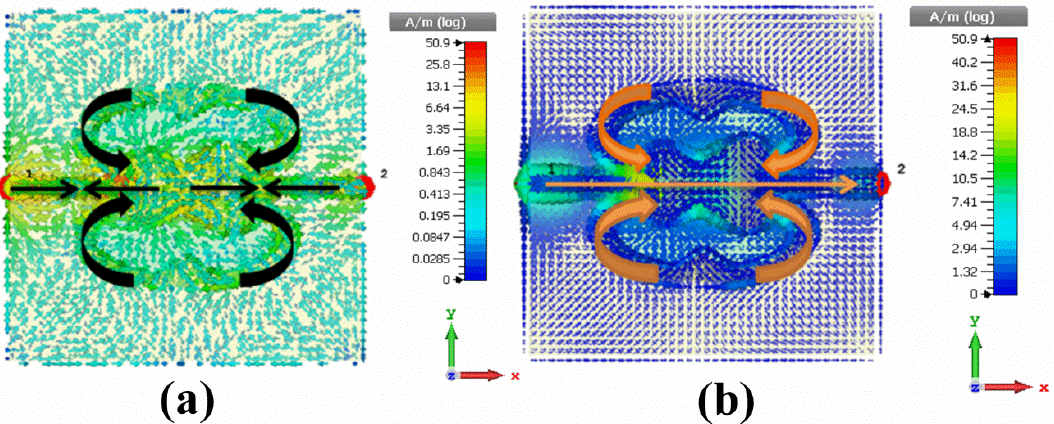
Figure 13. ( a ) Surface current distributions for branded diesel at 8.39 GHz and ( b ) unbranded diesel at 8.41 GHz.